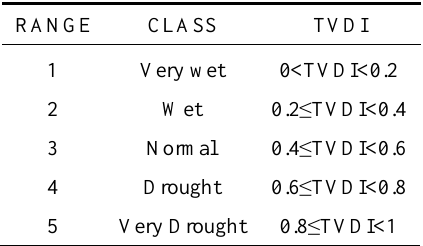
Table 1. Classification of drought levels using TVDI as an indicator